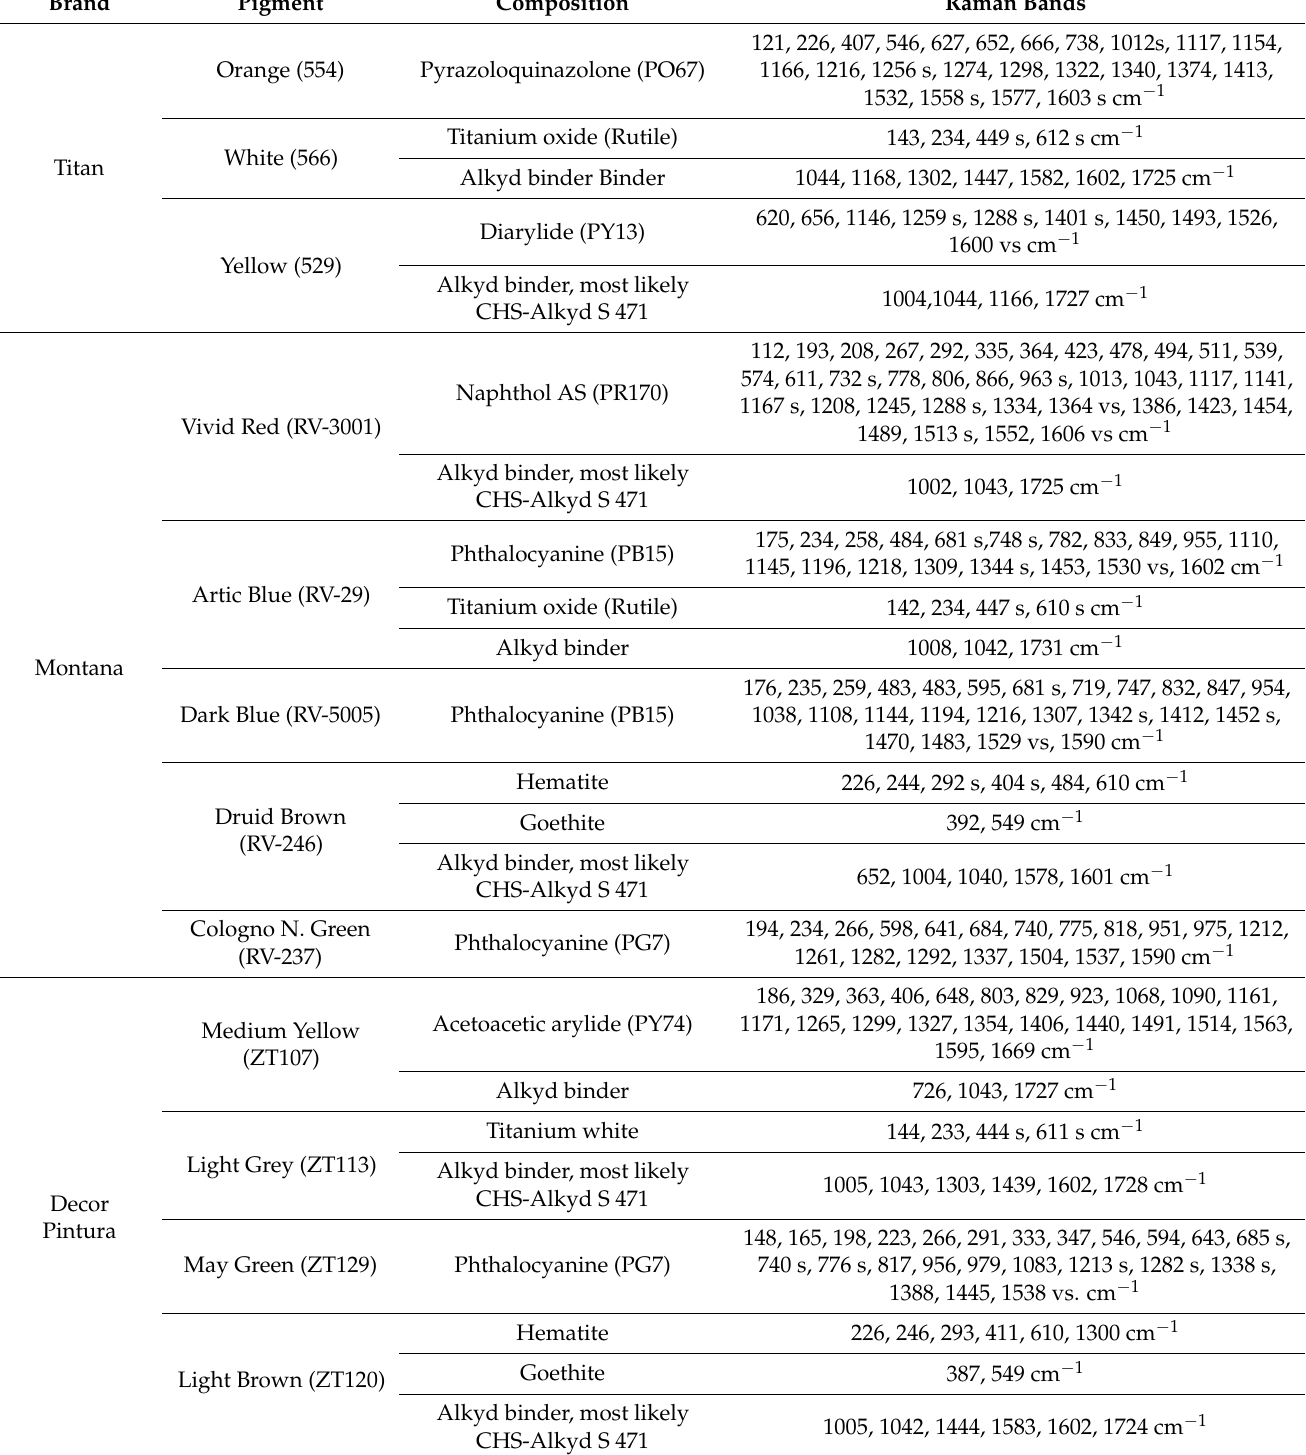
Table 2. Compounds identified by means of Raman spectroscopy in the commercial